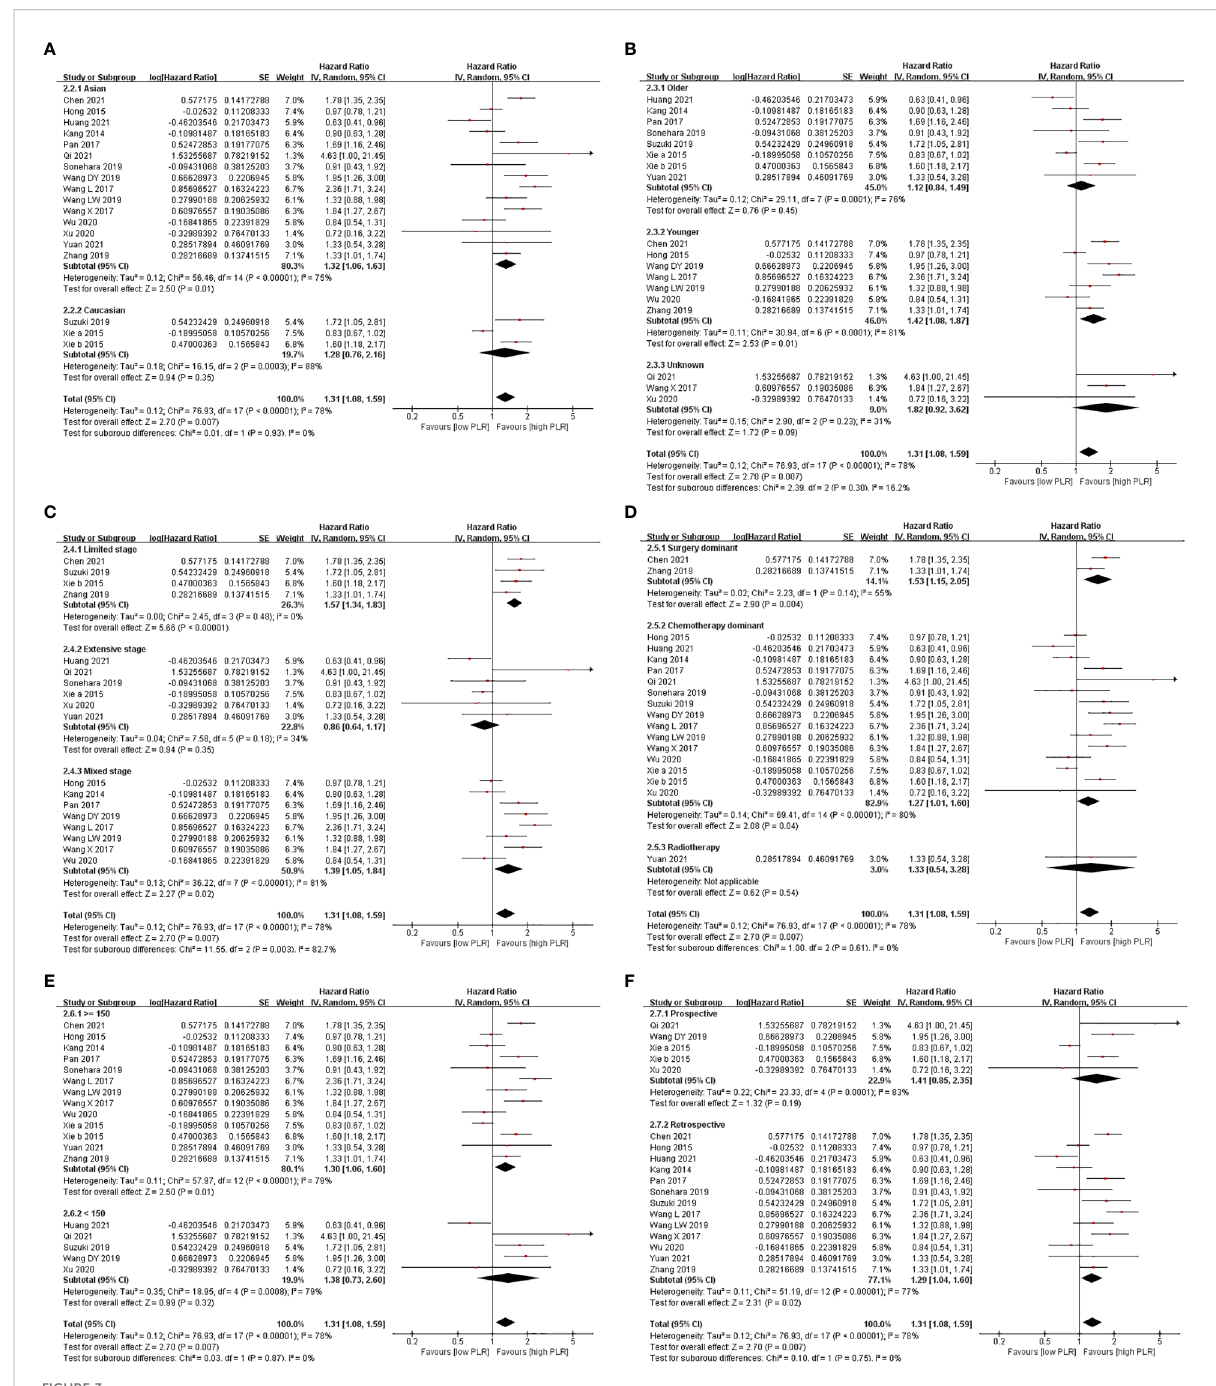
FIGURE 3 Subgroup analysis of associations between PLR and OS in SCLC patients summarized by multivariate model. (A) Ethnicity; (B) age; (C) stage; (D) treatment; (E) cutoff point; (F)